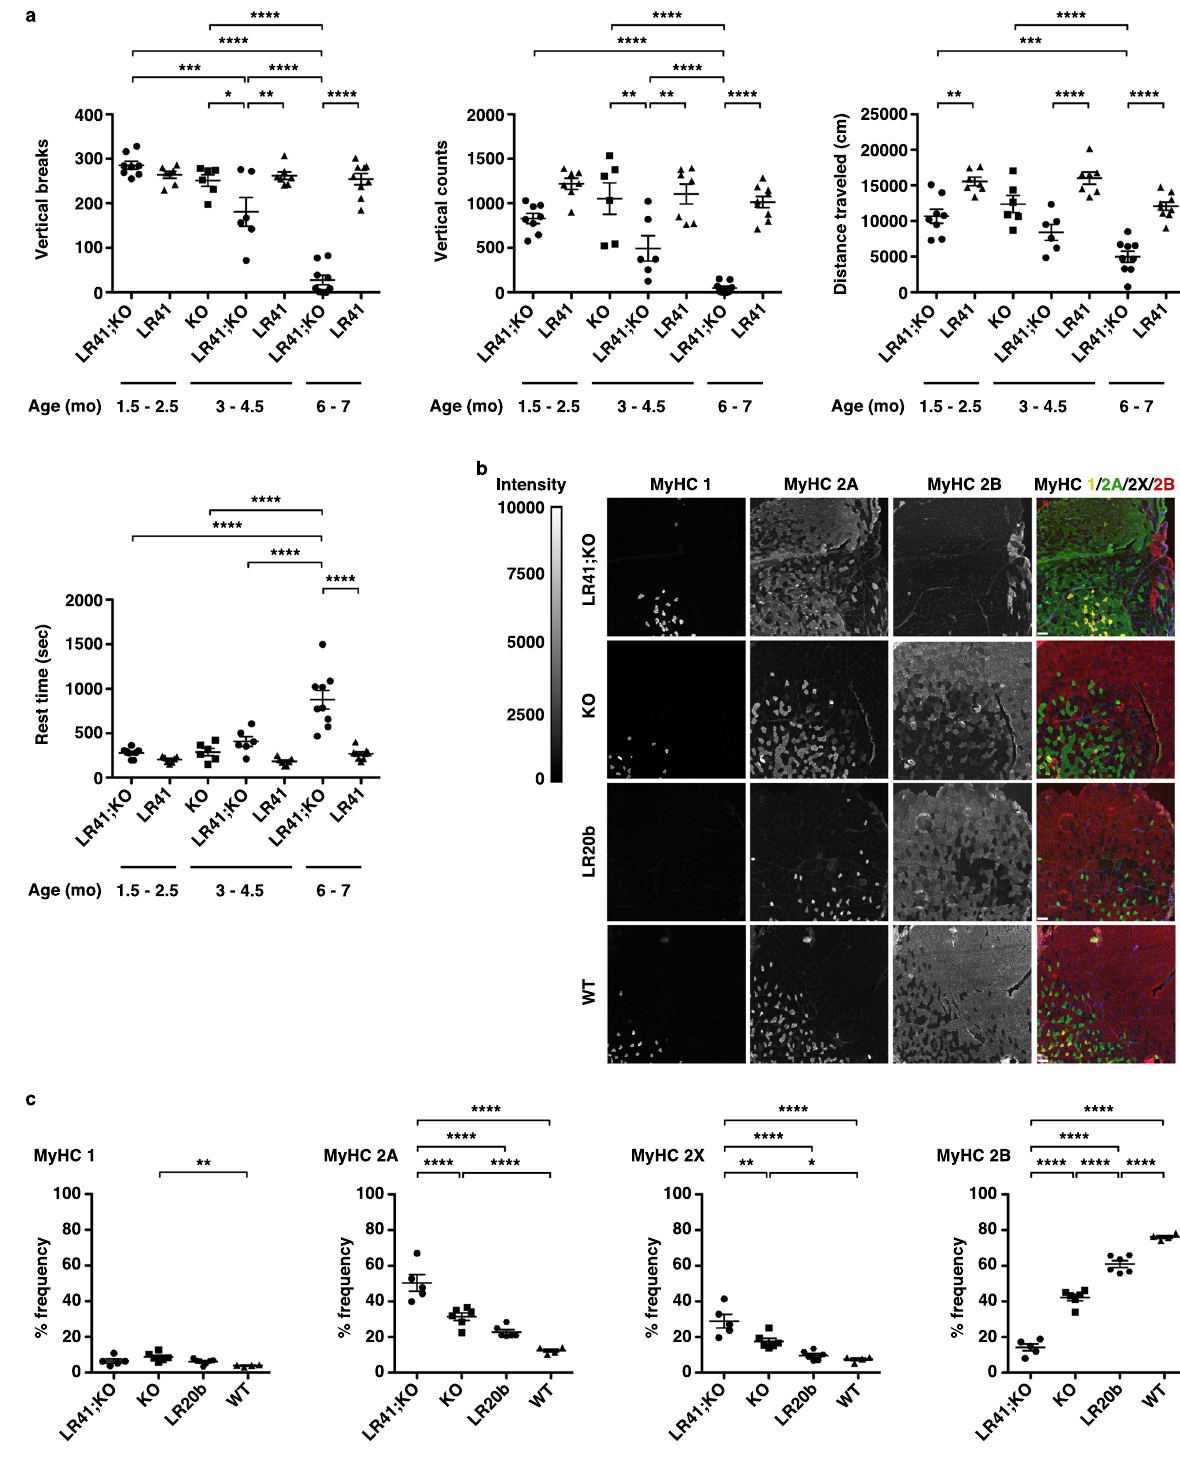
Fig. 1 | Progressive functional impairment and myosin fi ber type switch in the LR41; Mbnl1 − / − double homozygous mouse model of DM1. We crossed theHSA LR line41(LR41)transgenicmodelwiththemuscleblind-like-1knockout ( Mbnl1 − / − ) model to create the LR41; Mbnl1 − / − double homozygous model of DM1. a Quanti fi cation of spontaneous activity in LR41; Mbnl1 − / − , LR41 litter- mates, and Mbnl1 − / − alone as vertical breaks, vertical counts, total distance traveled(cm),andtime(seconds;sec)spentresting.Weexaminedmiceatages 1.5 – 2.5 months (mo) ( N =7 or 8 each group), 3.5 – 4.5 months ( N =6 or 7 each group),and6 – 7months( N =8or9eachgroup).Theaverageofvaluesforthree separate 30min monitoring sessions for each individual mouse is shown. **** P <0.0001; *** P <0.001; ** P <0.01; * P <0.05 (one-way ANOVA). Error bars Nature Communications| (2023) 14:1956